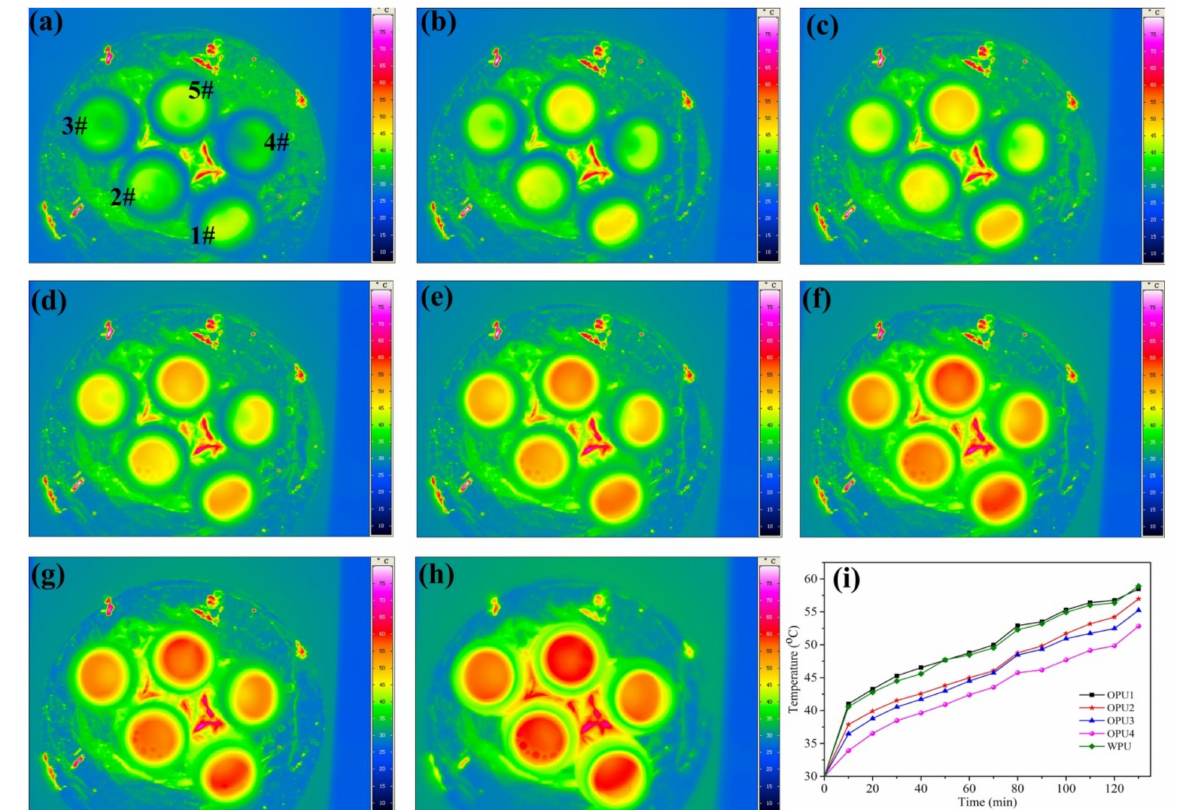
Figure 6. Infrared thermography of WPU and OPUs: ( a ) 0 min, ( b ) 20 min, ( c ) 40 min, ( d ) 60 min, ( e ) 80 min, ( f ) 100 min, ( g ) 120 min, ( h ) 140 min, ( i ) The variation of the surface temperature with